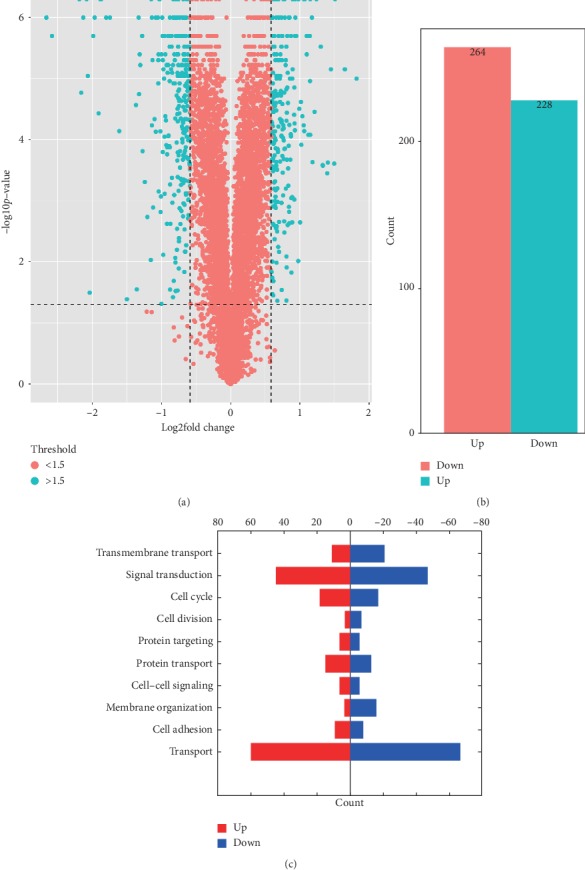
Screening and counting of total differential proteins by mass spectrometry (NPM1 silencing cisplatin-resistant bladder cancer cells and negative control). (a) is the volcanic maps of all proteins present in mass spectrometry. (b) shows the total number of differential screening proteins (fold change >1.5, p value<0.05). (c) shows the total number of differential proteins with biological function proved by GO analysis (fold change >1.5, p value<0.05).